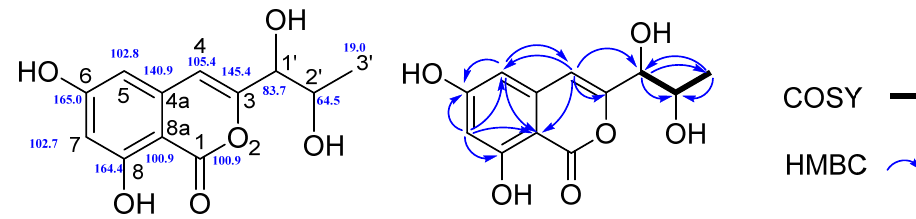
Figure 7. Signal assignment of compound 9 via 13 C and HMBC. Table 3. The 1 H, 13 C, HMBC, and HSQC NMR data for compound 9 in DMSO- d 6.